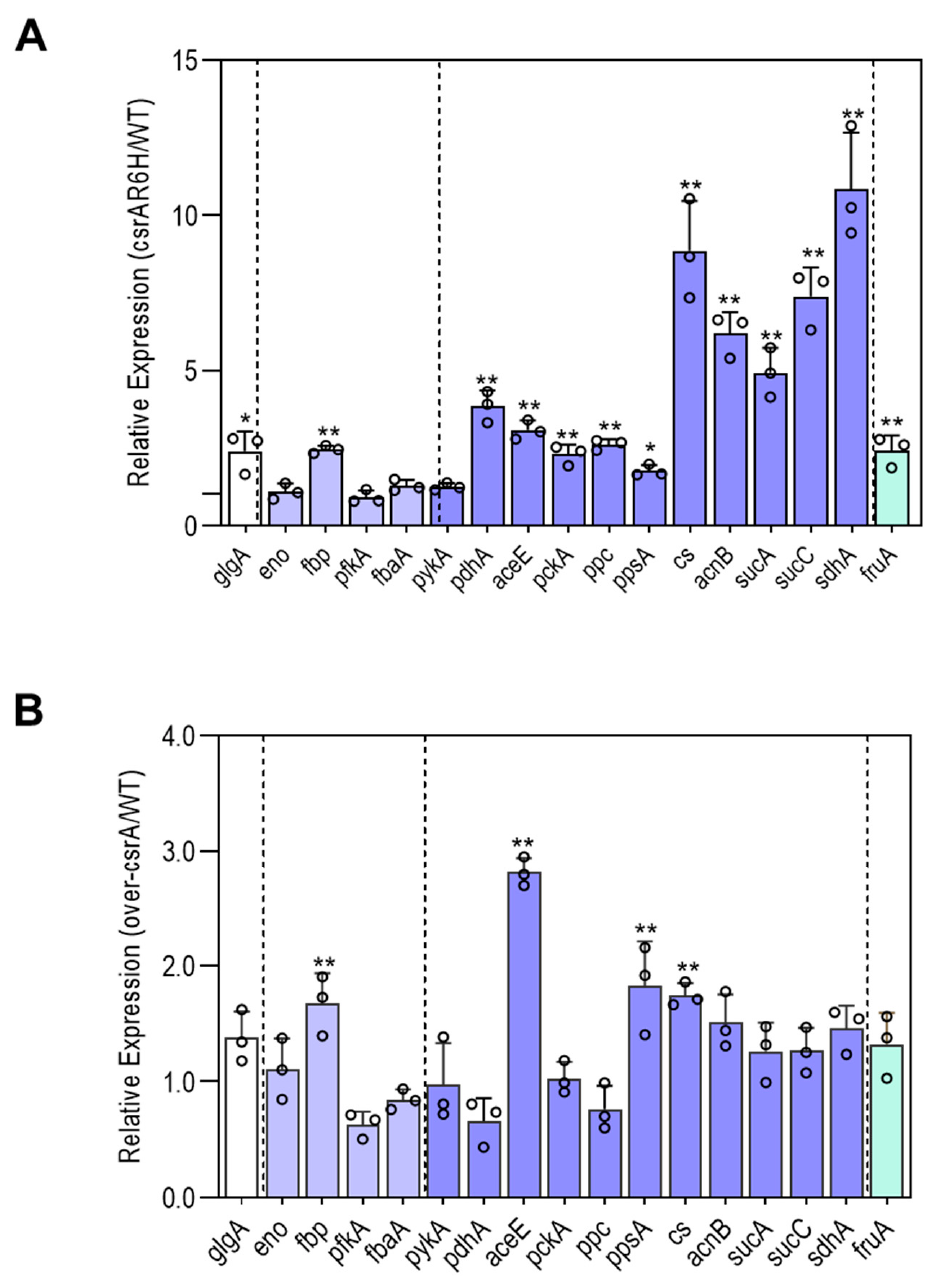
Figure 4. CsrA has a significant impact on the transcript abundance of genes involved in central metabolism. The color code matches the glucogenesis pathway ( glgA ), glycolysis pathway ( eno , fbp , pfkA , fbaA ), pyruvate cycle, TCA cycle ( pykA , aceE , pckA , pdhA , ppc , ppsA , cs , acnB , sucA , sucC , sdhA ), and nutrient transporter ( fruA ), respectively. ( A ) The relative expression of the csrA .R6H strain divided by that of the WT. ( B ) The relative expression of the over- csrA strain divided by that of the WT. The relative expression level of a set of genes was obtained for each strain from the integration of three biological replicates (see Materials and Methods for details). Data are presented as the mean ± SD; * p < 0.05, ** p < 0.01 by one-way ANOVA with the FDR post hoc test comparing ZJ_T- csrA R6H and ZJ_T/over- csrA -pSCT32 to the wild type.